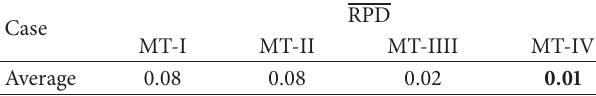
Table 6: Comparisons of different mutation types.